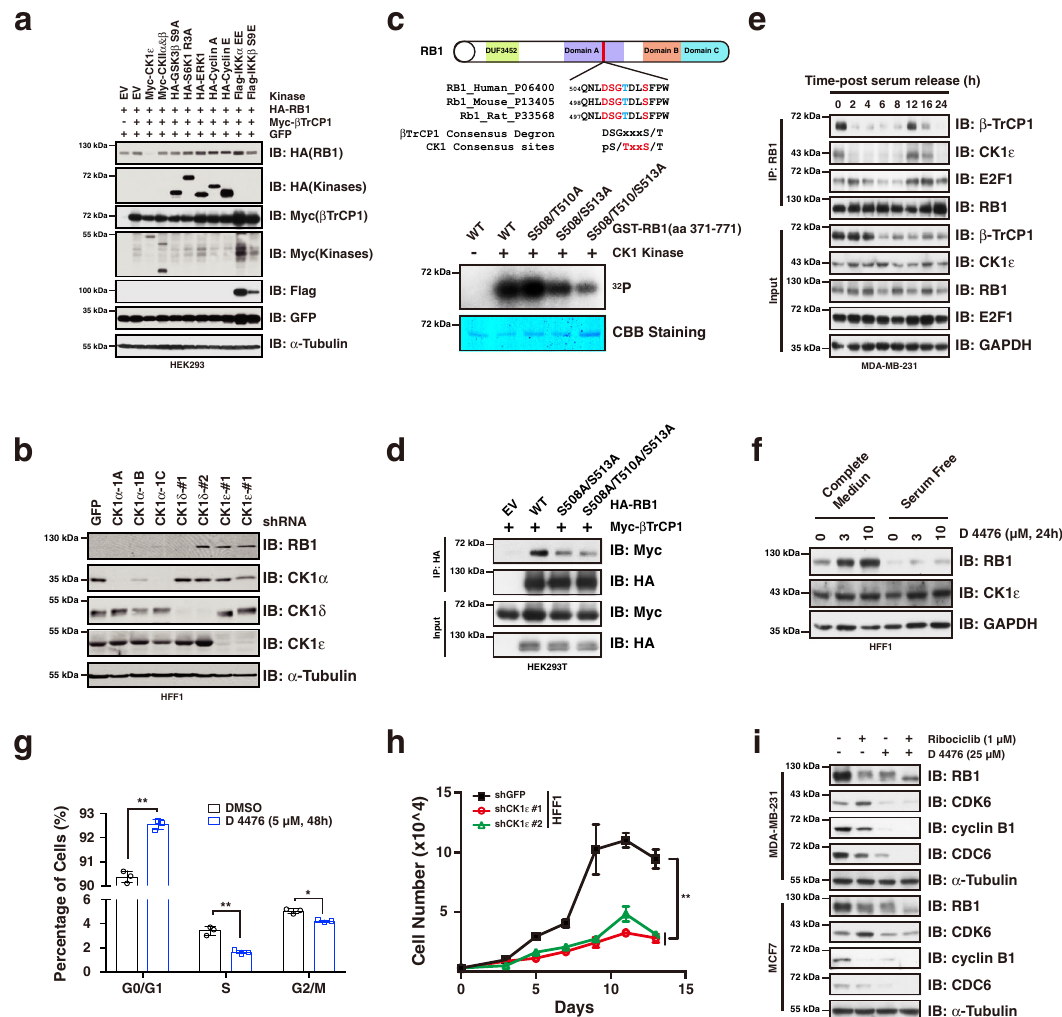
Fig. 3 Phosphorylation of RB1 by CK1 ε promotes β TrCP1-mediated degradation. a Ectopic expression of CK1 ε led to reduced RB1 protein abundance. b Knocking-down of CK1 ε resulted in RB1 accumulation in HFF1 cells. c In vitro kinase assay showing that CK1 ε can phosphorylate RB1 at S508/T510/ S513 sites. d Immunoprecipitation assay showing that mutation of the CK1 ε phosphorylation sites of RB1 diminished its interaction with β TrCP1. e Immunoprecipitation assay showing that RB1 speci fi cally interacted with β TrCP1 and CK1 ε in G1 phase. MDA-MB-231 cells were serum starved for 48 h followed by serum re-addition and harvested at indicated time points. f Inhibition of CK1 ε kinase using CK1 inhibitor D 4476 led to RB1 accumulation in a dose-dependent manner in HFF1 cells. g Employment of D 4476 led to increased cell population in G1 phase in HFF1 cells ( n = 3). The P values were calculated by Student ’ s t-test (two-sided). * P < 0.05, ** P < 0.01. h Knocking-down of CK1 ε suppressed HFF1 cell proliferation ( n = 4). Statistical differences were assessed by two-way ANOVA (two-sided). **: P < 0.01. i Combination of D 4476 prevented ribociclib treatment induced RB1 degradation and CDK6 accumulation in MCF7 and MDA-MB231 cells. Data are presented as mean values ± SEM. The relevant raw data and uncropped blots are provided in Source